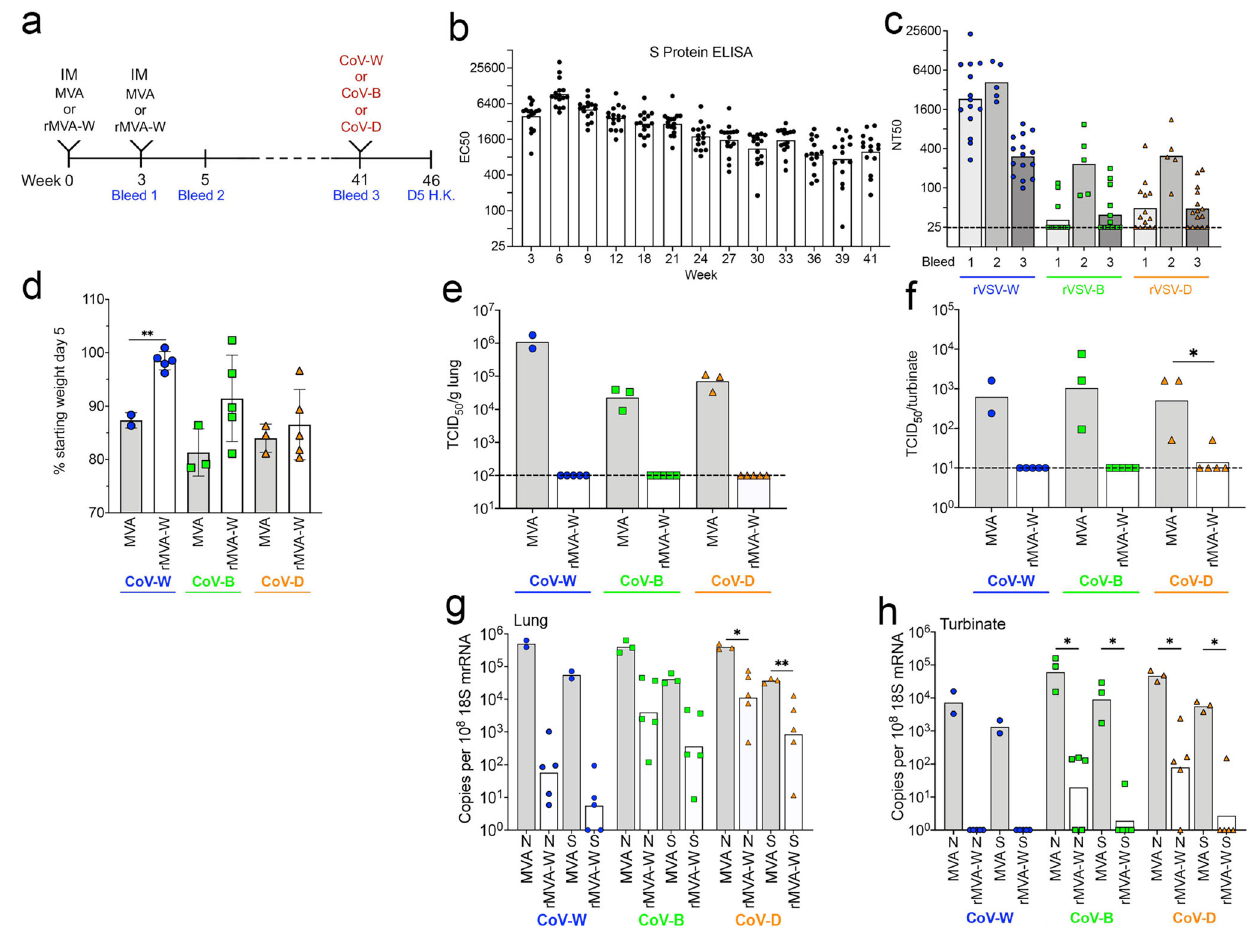
Fig. 2 Duration of cross-protective immunity following IM vaccination with rMVA-W. a Timeline of K18-hACE2 mice vaccinated IM twice with 2 × 10 7 PFU of MVA control ( n = 8) divided into groups of 2 – 3 or rMVA-W ( n = 15) divided into groups of 5 and challenged with 10 4 TCID 50 of CoV-W, -B, or -D approximately 9 months later. Mice were H.K. 5 days after challenge. b Binding of serum antibodies elicited by vaccination with rMVA-W to Wuhan S protein determined by ELISA ( n = 15). c Neutralization of pseudoviruses rVSV-W, -B and -D by serum obtained at weeks 3, 5, and 41 ( n = 15). d Weights of mice on day 5 after challenge relative to starting weights (MVA n = 2 or 3; rMVAs N = 5 per group). Recovery of SARS-CoV-2 from e lungs and f nasal turbinates on day 5 after challenge (n as in d ). Copies of sgRNAs N and S relative to 18 S rRNA from g lungs and h nasal turbinates on day 5 after challenge (n as in e , f ). Statistics: for D, F, H Welch ’ s t-test. * p ≤ 0.03; ** p ≤ 0.002. Dotted line, limit of